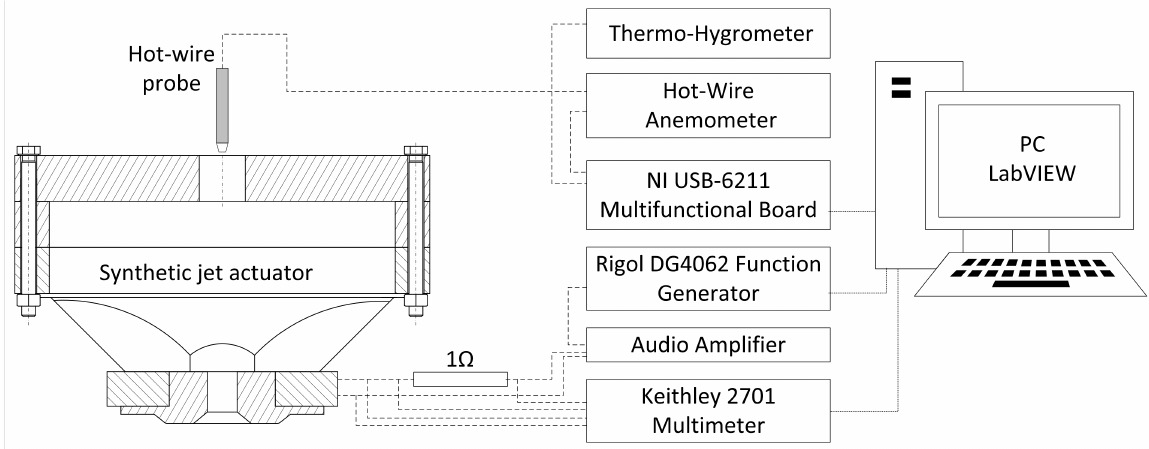
Figure 3. Scheme of the measurement system.